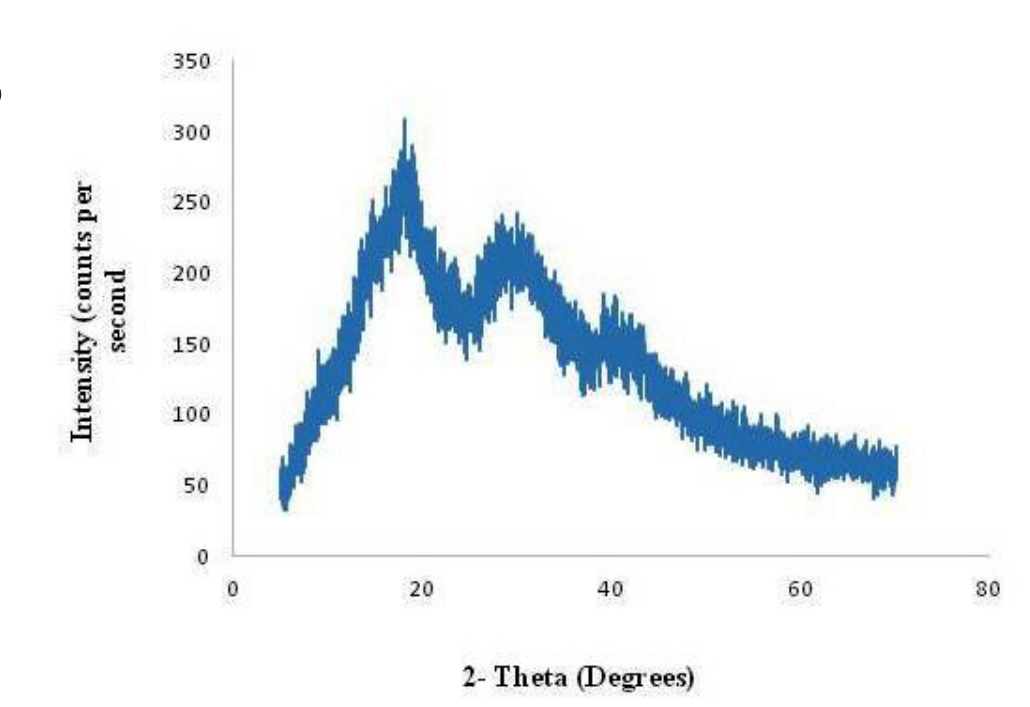
FIGURE 10 - (a) XRD of Ketoprofen. (b) XRD of Physical Mixture of Batch P2p [Ketoprofen: Polo (1:1.5)]. (c) XRD of Solid dispersion of Batch P2 [Ketoprofen: Polo (1:1.5)]. (d) XRD of Physical Mixture of Batch E1p [Ketoprofen: Eud (1:1)]. (e) XRD of Solid Dispersion of Batch E1 [Ketoprofen: Eud